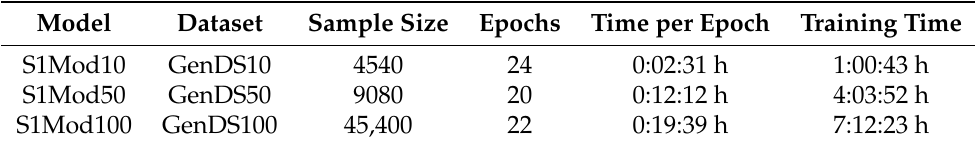
Table 2. Training stage 1.